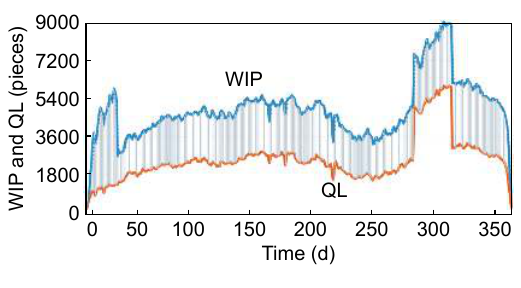
Fig. 6 Trend line of WIP and